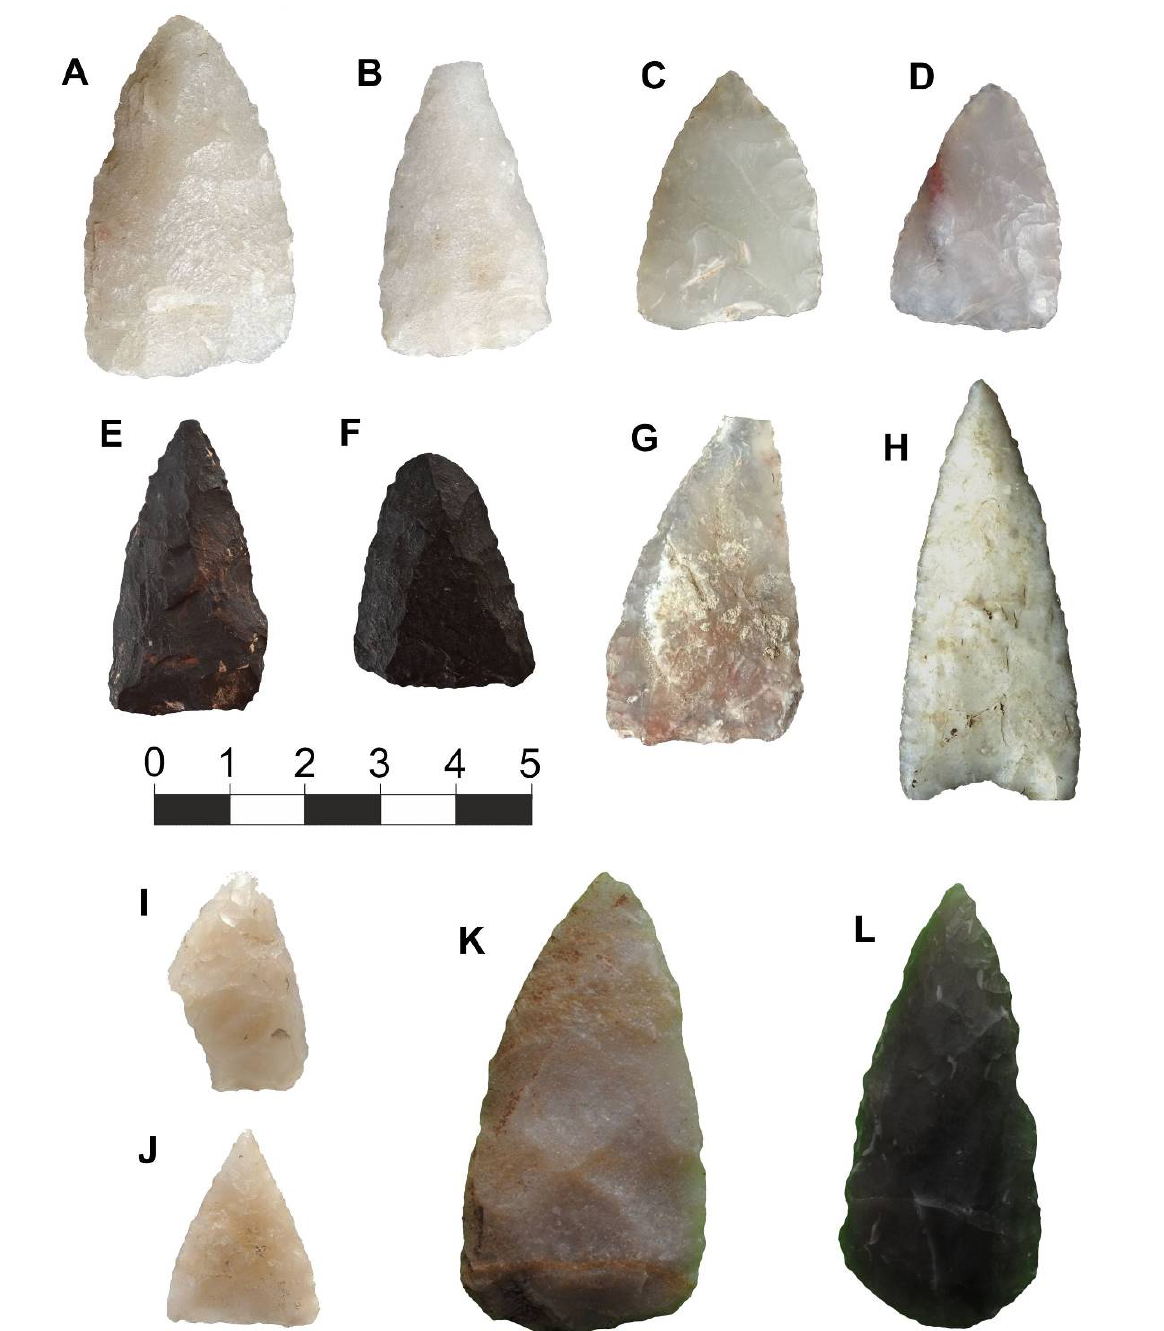
Figure 6. Projectile points found in the Aeolian System of central Argentina. Upper and middle files: Projectile points found in the CPD: A-B- Orthoquartzite from Tandilia Hill (Laguna Chica site); C-D- Chert from Tandilia Hill (Laguna Chica site); E- Rhyolite from Ventania Hill (La Susana 1 site); F- Basalt from the Atlantic coast or the xerophytic woodland (Laguna Chica site); G- Silicified limestone from the xerophytic woodland (Laguna Chica site); H- Chalcedony from the xerophytic woodland (Laguna Chica site). Lower file: Projectile points found in the WPMD and WPD areas: I- Chert from Tandilia Hill (Manantial Naicó site); J- Orthoquartzite from Tandilia Hill (Parque Luro site) (Photos courtesy of Manuel Carrera Aizpitarte); K- Ortoquartize from Tandilia Hill (La Angelita site), L- Chert from Tandilia Hill (La Angelita site) (Photos courtesy of Guillermo